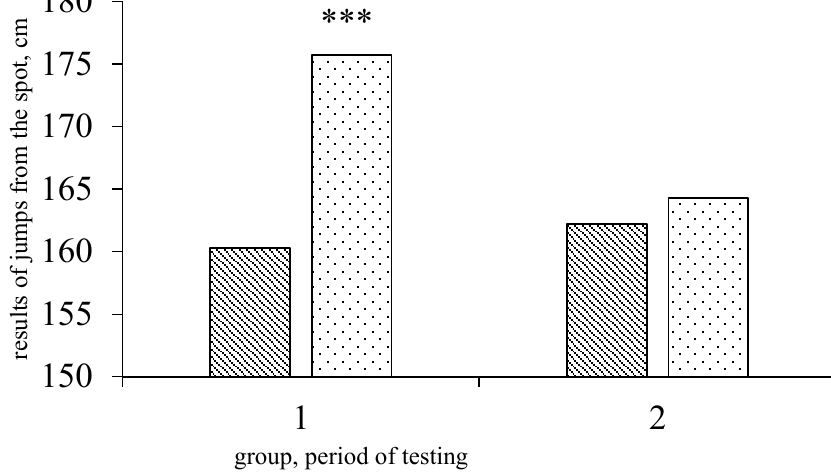
Fig. 1. Results of test “Long jump from the spot” of experimental (n=34) and control (n=34) groups before and after